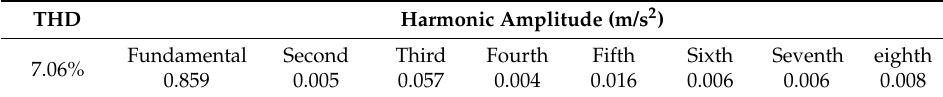
Table 2. Total harmonic distortion (THD) analysis